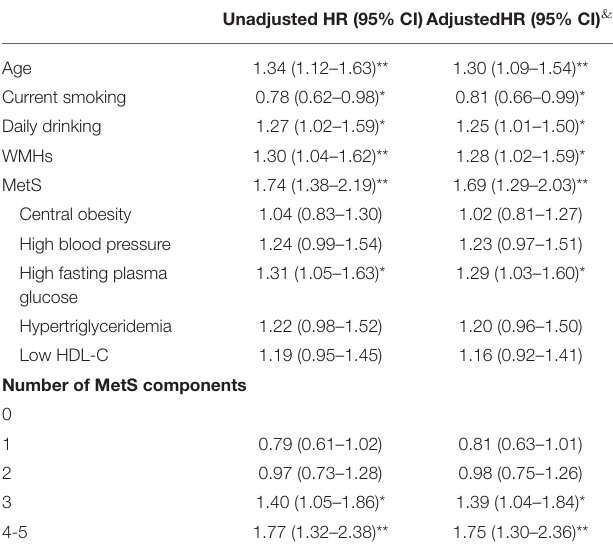
TABLE 2 | Association of baseline characteristics with PD